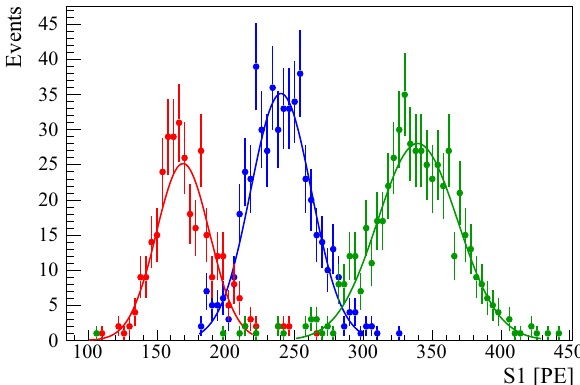
Fig. 20 Primary scintillation light (S1) from 83 m Kr 32.1keV con- version electron events in detector regions close to the central axis ( R = 8 ... 16cm) but at different heights: just below the gate (red), in the TPC center (blue) and above the cathode (green). These spectra were used to construct the correction map shown in Fig. 21